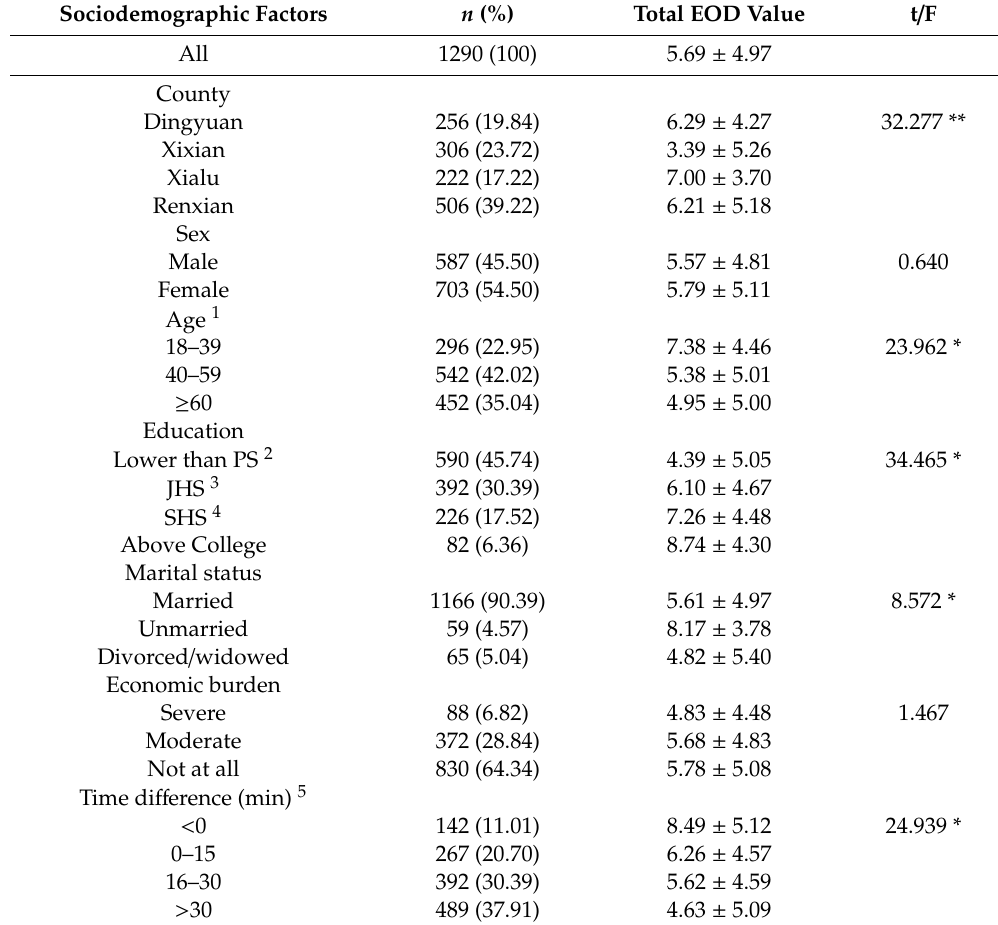
Table 1. Characteristics of the samples ( n ,%; n =